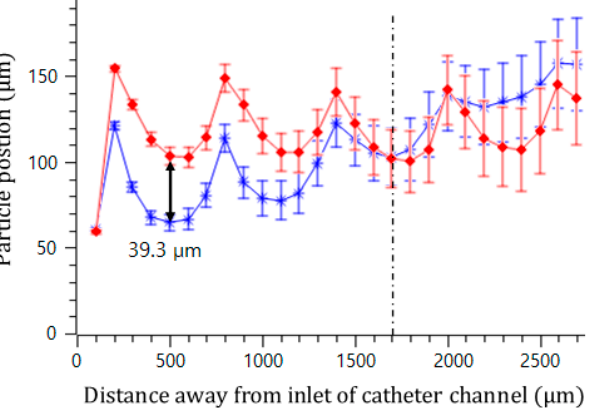
Figure 7. Trajectory of microsphere movement in the catheter channel with a bubble height of 102 µ m (red diamond) and a bubble height of 60 µ m (blue asterisk).